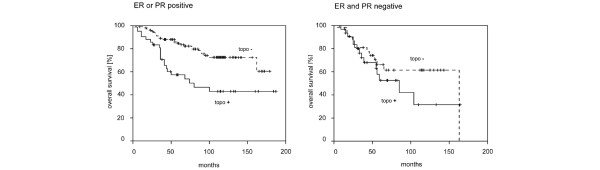
Prognostic impact of topoisomerase IIα protein expression with regard to hormone status. Patients with tumors positive for topoisomerase IIα in more than 25% of tumor cells (solid lines) were compared with those having tumors expressing topoisomerase IIα in less than 25% of cells (dashed lines) with regard to the hormone status. The difference was significant in tumors positive for estrogen receptor or progesterone receptor (log rank 12.0; P = 0.0005).